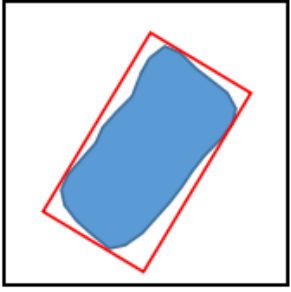
Figure 9. A diagram of minimum area bounding